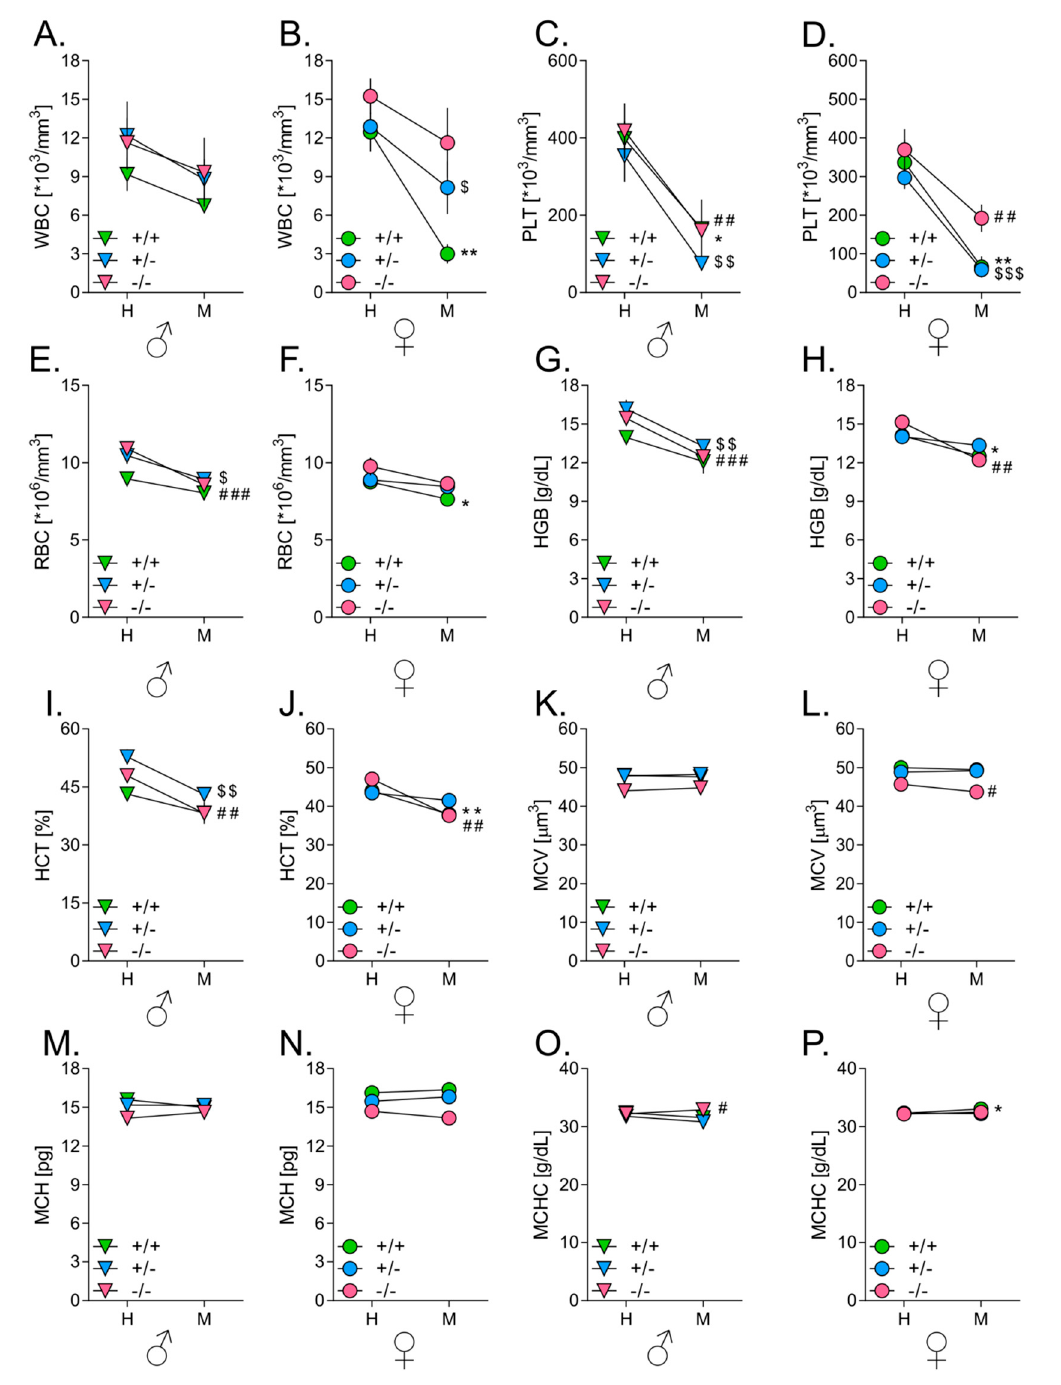
Figure 6. Effect of HO-1 expression in mice on hematological parameters. ( A ) White blood cells (WBC) in males. ( B ) WBC in females. ( C ) Platelets (PLT) in males. ( D ) PLT in females. ( E ) Red blood cells (RBC) in males. ( F ) RBC in females. ( G ) Hemoglobin (HGB) in males. ( H ) HGB in females. ( I ) Hematocrit (HCT) in males. ( J ) HCT in females. ( K ) Mean corpuscular volume (MCV) in males. ( L) MCV in females. ( M ) Mean corpuscular volume (MCH) in males. ( N ) MCH in females. ( O ) Mean corpuscular hemoglobin concentration (MCHC) in males. ( P) MCHC in females. Analysis of blood parameters by means of ABC Vet. Intact, Healthy (H) vs. Tumor-bearing, Metastatic (M). Each bar represents mean ± SE ( N = 4–8; * p < 0.05, ** p < 0.01, tumor-bearing HO-1 +/+ mice vs. intact HO-1 +/+ mice; $ p < 0.05, $$ p < 0.01, $$$ p < 0.001 tumor-bearing HO-1 +/ − mice vs. intact HO-1 +/ − mice; # p < 0.05, ## p < 0.01, ### p < 0.001 tumor-bearing HO-1 − / − mice vs. intact HO-1 − / − mice).